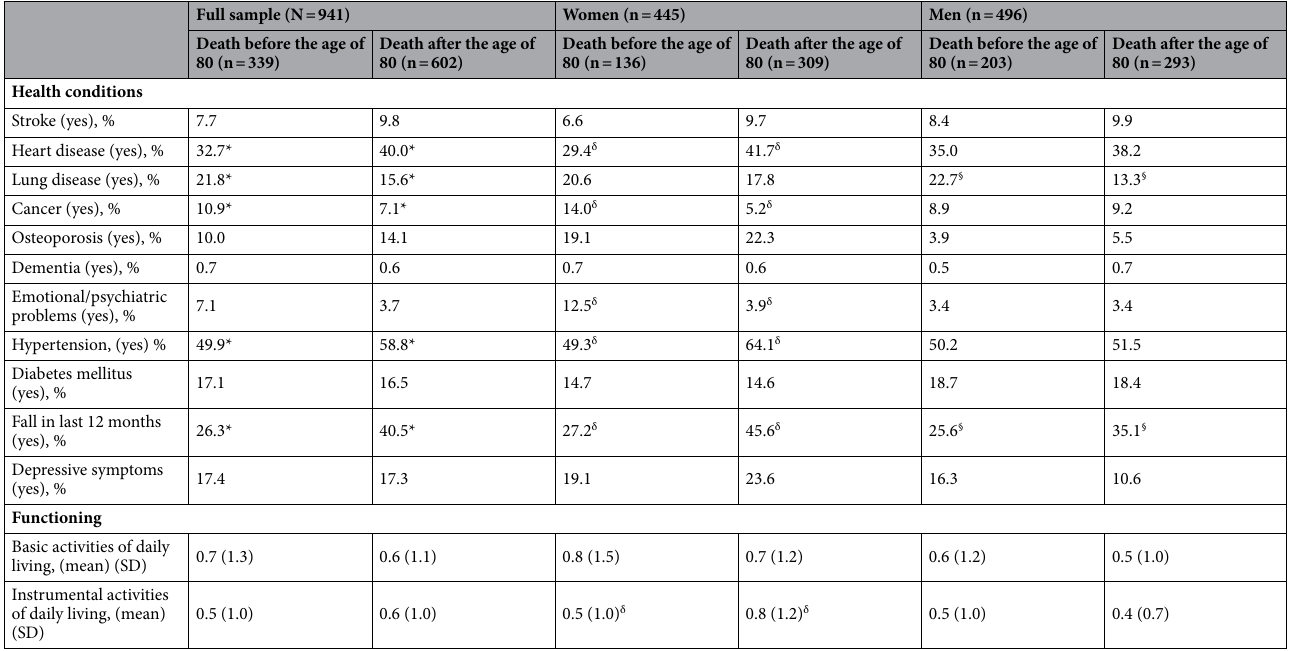
Table 2. Baseline clinical and functional characteristics who died before and after the age of 80 during 12-month follow-up. *Differences between full sample in category ’death before the age of 80’ versus full sample in category ’death after the age of 80’. δ Difference between women in category ’death before the age of 80’ versus women in category ’death after the age of 80’; § Difference between men in category ’death before the age of 80’ versus men in category ’death after the age of